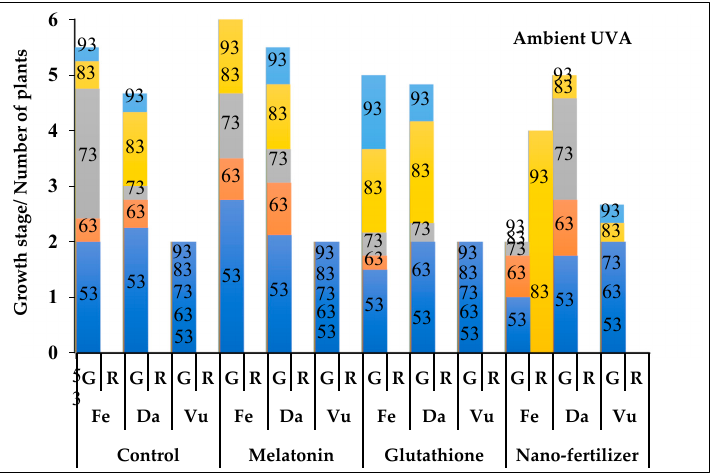
Figure 3. The phenological stages of Thymus fedtschenkoi (Fe), T. daenensis (Da) and T. vulgaris (Vu) under ambient UVA and following application of protectant compounds [water (control), melatonin, glutathione, iron-zinc nanofertilizer]. Both the rate of growth (G) and of rosette (R) are provided. Numbers on the columns represent days after pruning. For G column, the y-axis scale represents the following stages: 0–1, early vegetative stage (active growth or 4–6 leaf stage); 1–2, late vegetative stage (stem development); 2–3, budding stage (20% budding); 3–4, full budding stage; 4–5, early flowering stage; and 5–6, full flowering stage. For R column, the y-axis scale represents the number (out of 4) of rosette plants.